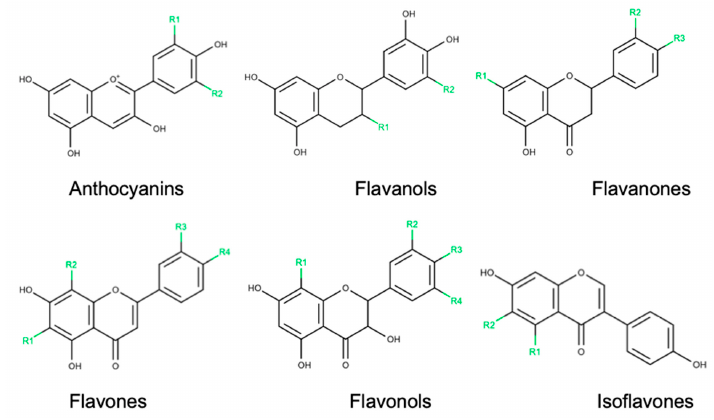
Figure 1. Chemical structures of flavonoid subclasses.